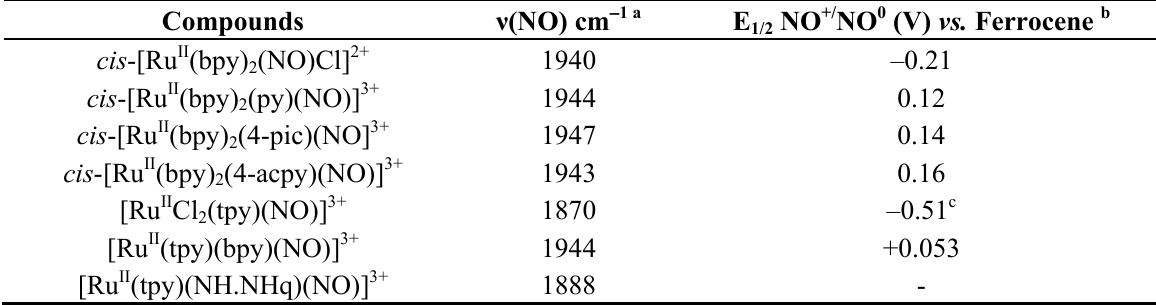
Table 1. Infrared data and NO +/0 redox potential for nitrosyl polypyridine ruthenium